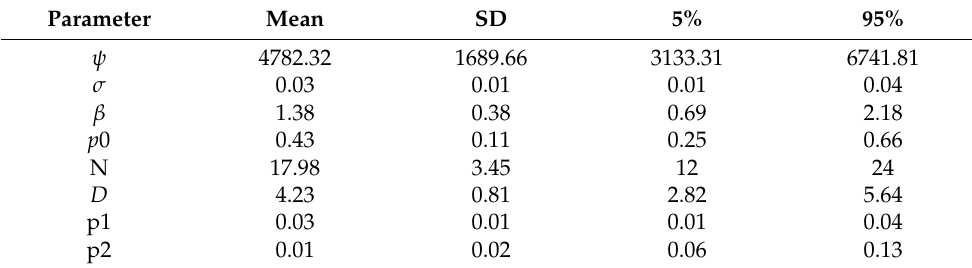
Table 2. Posterior summaries of the parameters of SECR model for the North China leopard camera trapping data in terms of the 12 observed individuals. Note: N is the number of North China leopard activity centers in the population exposed to sampling, D is the density per 100 km 2 , ψ is the data augmentation parameters, σ is the parameter in the bivariate normal pdf, β is regression coefficient that measures the behavioral response, and p0 is detection probability; the estimates of p1 and p2 are also reported. p1 is the encounter probability for individuals that have not previously been encountered, and p2 is the encounter probability for individuals subsequent to their initial encounter. Parameter Mean SD 5% 95% ψ 4782.32 1689.66 3133.31 6741.81 σ 0.03